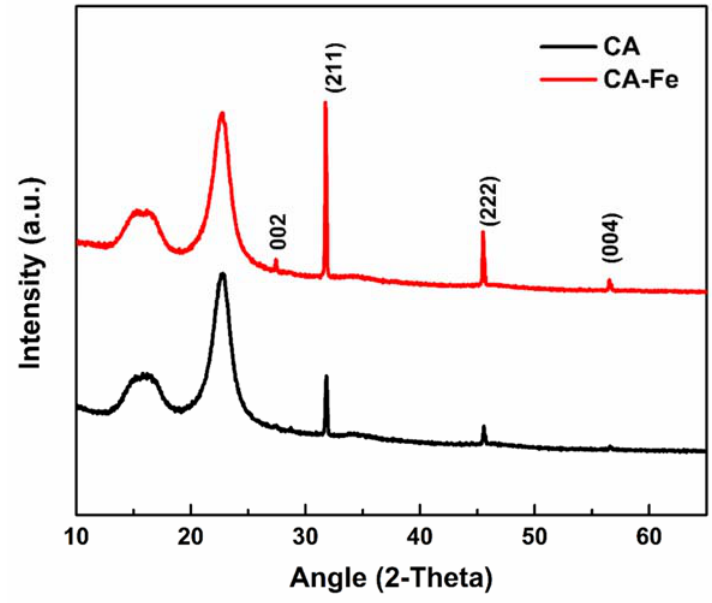
Figure 6. XRD of the different mats after 15 days of biomineralization.